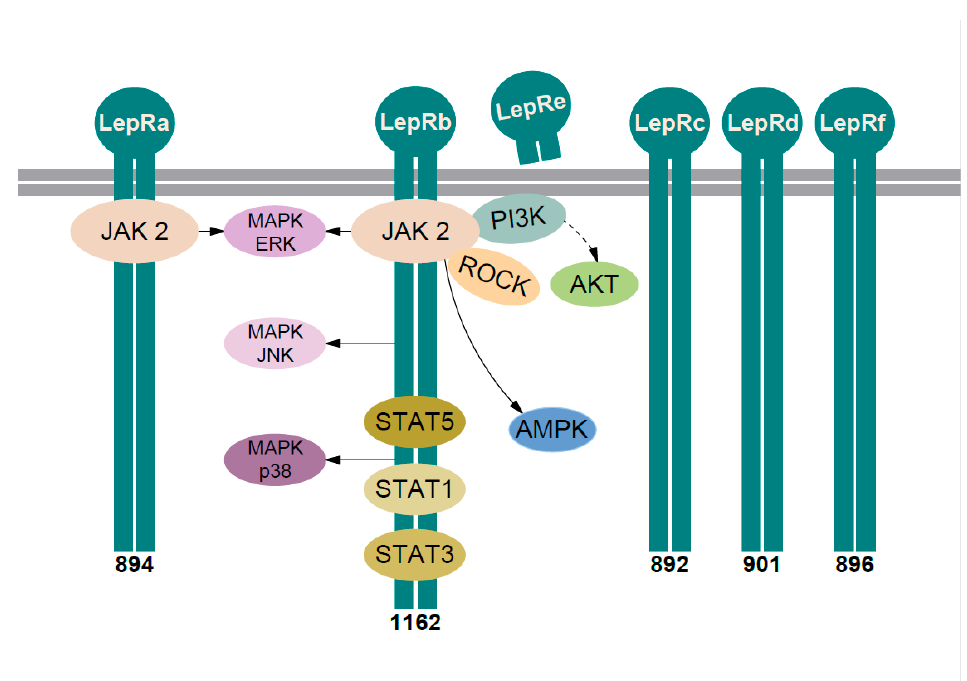
Figure 2. Leptin signaling pathways. Six isoforms of the leptin receptor are obtained by alternative splicing and named LepRa–LepRf. All isoforms share identical extracellular binding and trans- membrane domain. LepRe is the soluble receptor isoform—a cleavage product of the extracellular domain of the LepRb. Five isoforms—LepRa–LepRd and LepRf—are bound to the cell membrane (depicted as two thick gray lines). Their intracellular domains differ—the number below isoform indicates the number of amino acids in the intracellular domain. LepRb possesses the longest intracellular domain and contains motifs for the complete activation of the JAK2/STAT pathway. After leptin binds the LepRs they oligomerize (here depicted only as dimerization) and activate associated JAK2. The autophosphorylated JAK2 can lead to the activation of PI3K/AKT, ROCK (Rho/ROCK), and AMPK pathway. JAK2 phosphorylates LepRb, the three important tyrosine residues in the cytoplasmic tail (Tyr985/1077/1138). Via phospho-Tyr985 activated at least three MAPK pathways: ERK, JNK, and p38. STAT5 binds to phospho-Tyr1077 and phospho-Tyr1138, while STAT1 and STAT3 bind to phospho-Tyr1138. LepRa also activates JAK2 and MAPK-ERK pathway. Solid arrow—one or more proteins in the pathway. Dashed arrow—more proteins in the pathway. LepR—leptin receptor, JAK2—Janus-activated kinase 2, STAT—signal transducer and activator of transcription, PI3K—phosphatidylinositol 3-kinase, AKT—Protein kinase B, also known as Akt, ROCK—Ras homolog gene family/Rho-associated coiled-coil-forming protein kinase, AMPK—adenosine monophosphate-activated protein kinase, MAPK—mitogen-activated protein kinase, ERK—extracellular signal-regulated kinase, JNK—c-Jun-N-terminal kinase. See text for more